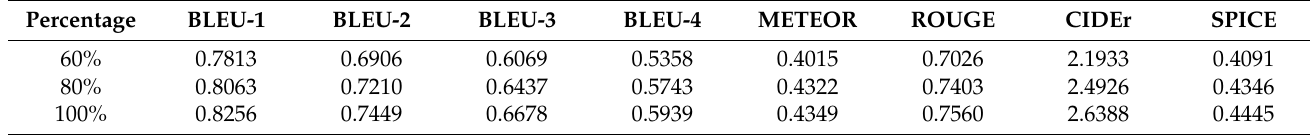
Table 5. Percentage sampling experimental results on Sydney-Captions